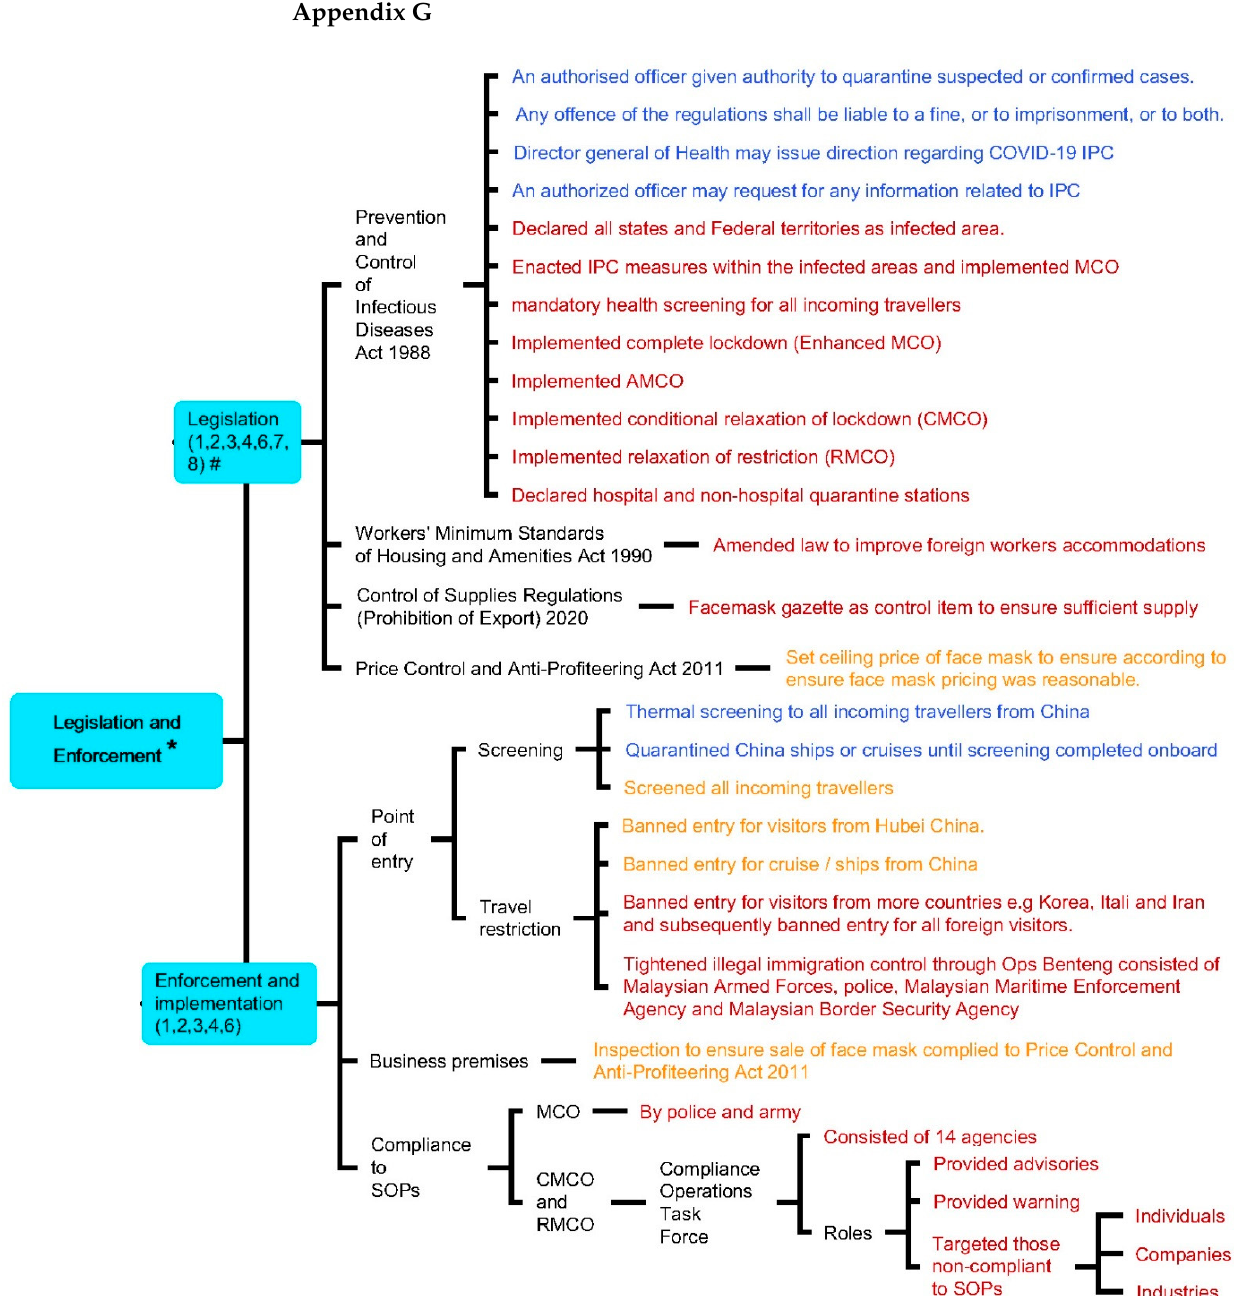
Figure A5. Relevant laws and regulations enforced by Malaysia in response to the COVID-19 pandemic. # Numbers in parentheses denote WHO Pillars. * Measures implemented: (i) before the first wave (31 December to 24 January) indicated in blue, (ii) during the first wave (25 January–26 February) indicated in orange, and (iii) during the second wave (27 February onwards) indicated in red.